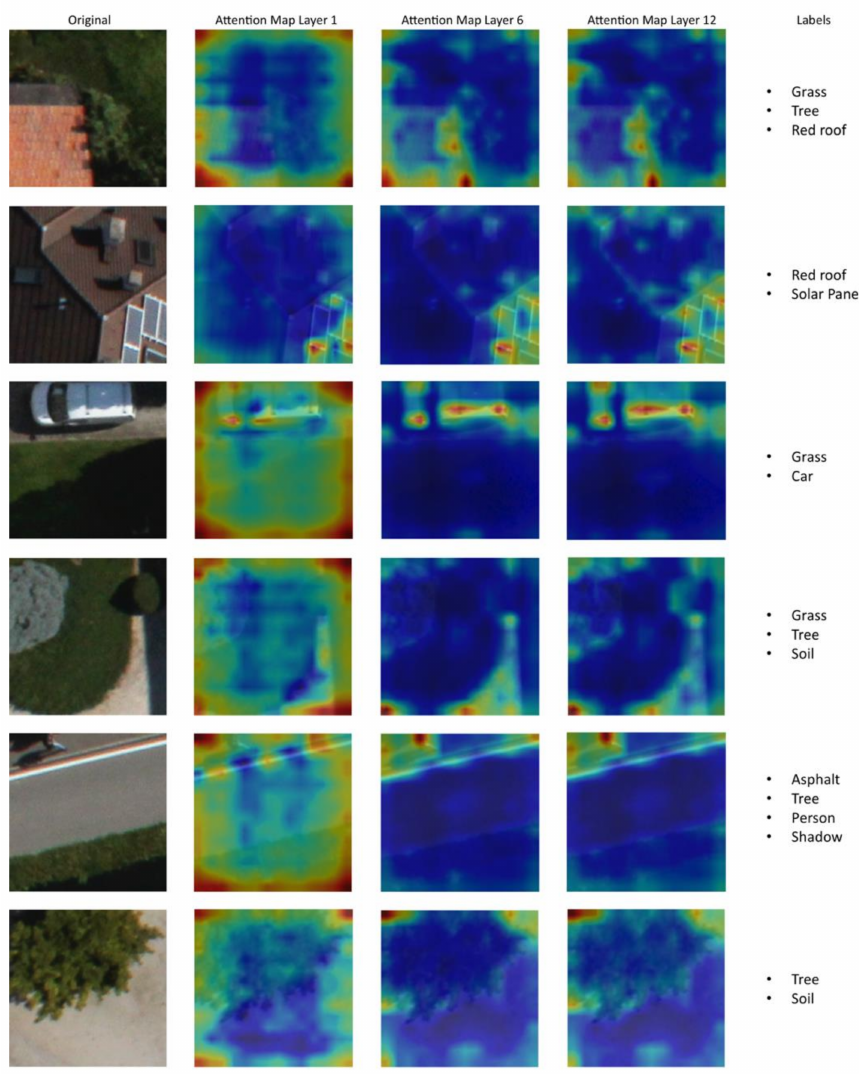
Figure 6. Attention heat maps generated by the first, sixth, and last layers of the encoder for classifying different samples from Trento multi-label